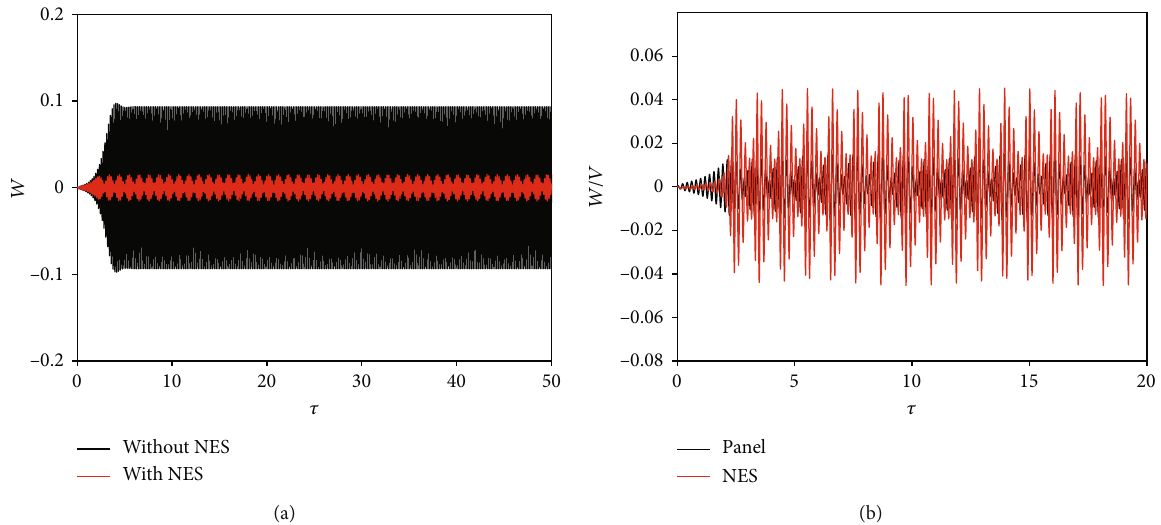
Figure 8: Time history at λ = 355 : (a) responses of the panel with and without an NES; (b) responses of the NES and panel.